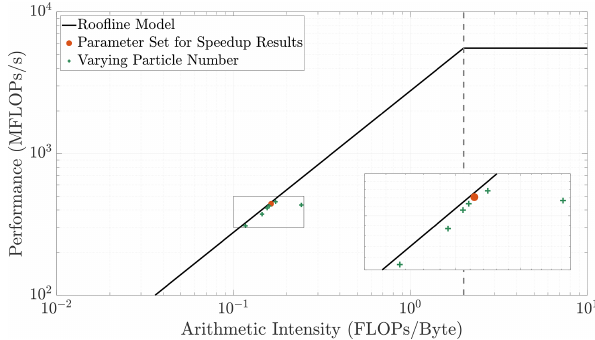
Figure A1. This figure displays the full roofline plot with an en- larged inset to accentuate the data trends. The data points corre- spond to various particle densities while domain size is held con- stant. As arithmetic intensity fluctuates, we observe that the algo- rithm’s performance is limited by the hardware’s bandwidth. We use the chosen parameter set (orange circle) for our speedup results since it (1) is the most efficient, (2) displays high accuracy from its particle count, and (3) is not memory-bound and does not require exceedingly long simulation